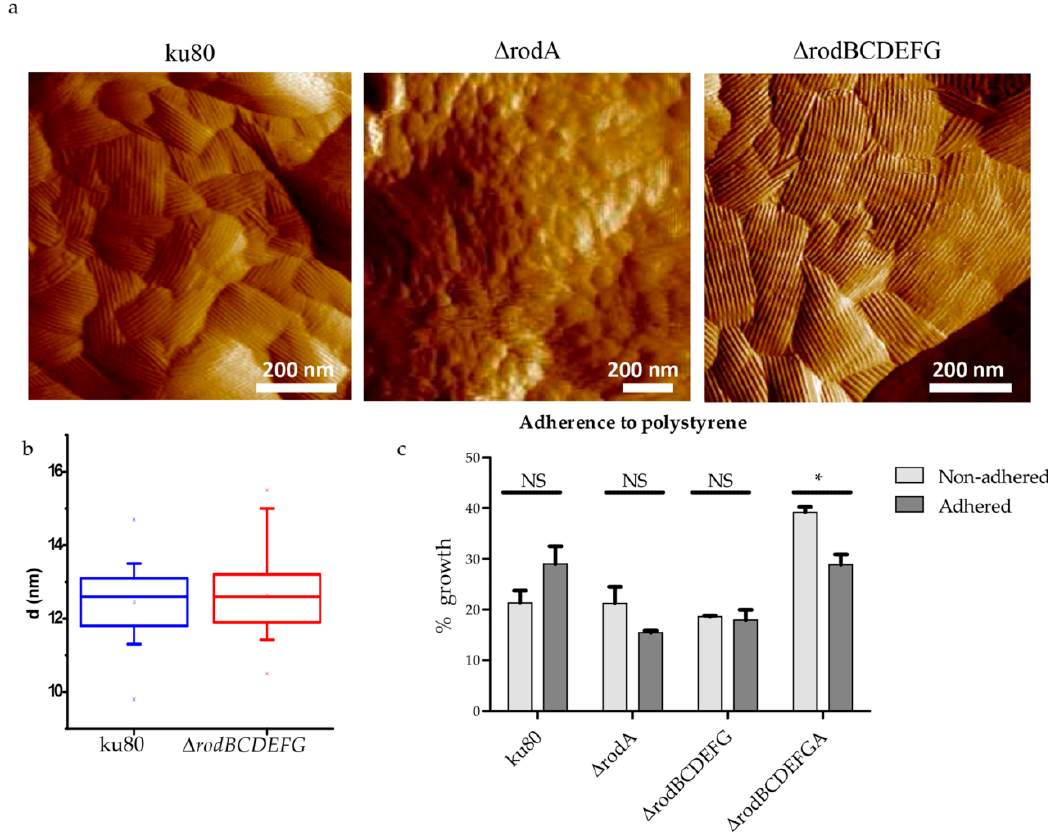
Figure 5. Structure of the conidial cell wall surface of ku80, ∆ rodA , and ∆ rodBCDEFG conidia. AFM images show the presence of rodlets on the surface of ku80 and ∆ rodBCDEFG , whereas the surface of conidia deleted in RODA is amorphous ( a ); box plots showing the distance between two rodlets on ku80 and ∆ rodBCDEFG conidia ( n = 20 in both cases) ( b ); and adherence to polystyrene plates of hydrophobin mutant and parental strain conidia ( c ). NS: not significant, * p < 0.05.